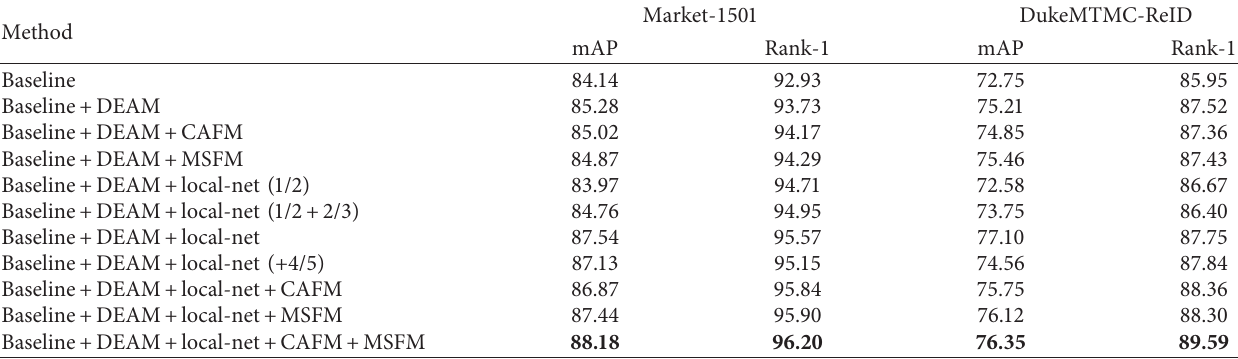
Table 1: Ablation experiment results of each module.